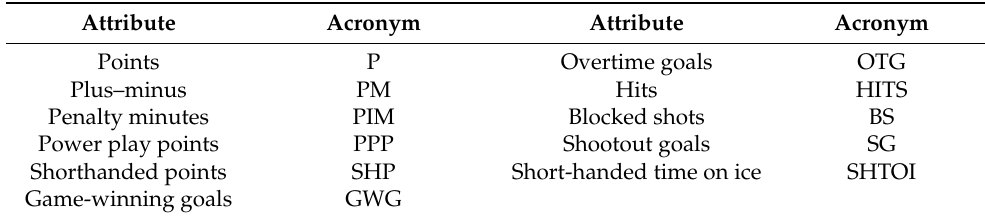
Table 2. Resulting structure of monitored